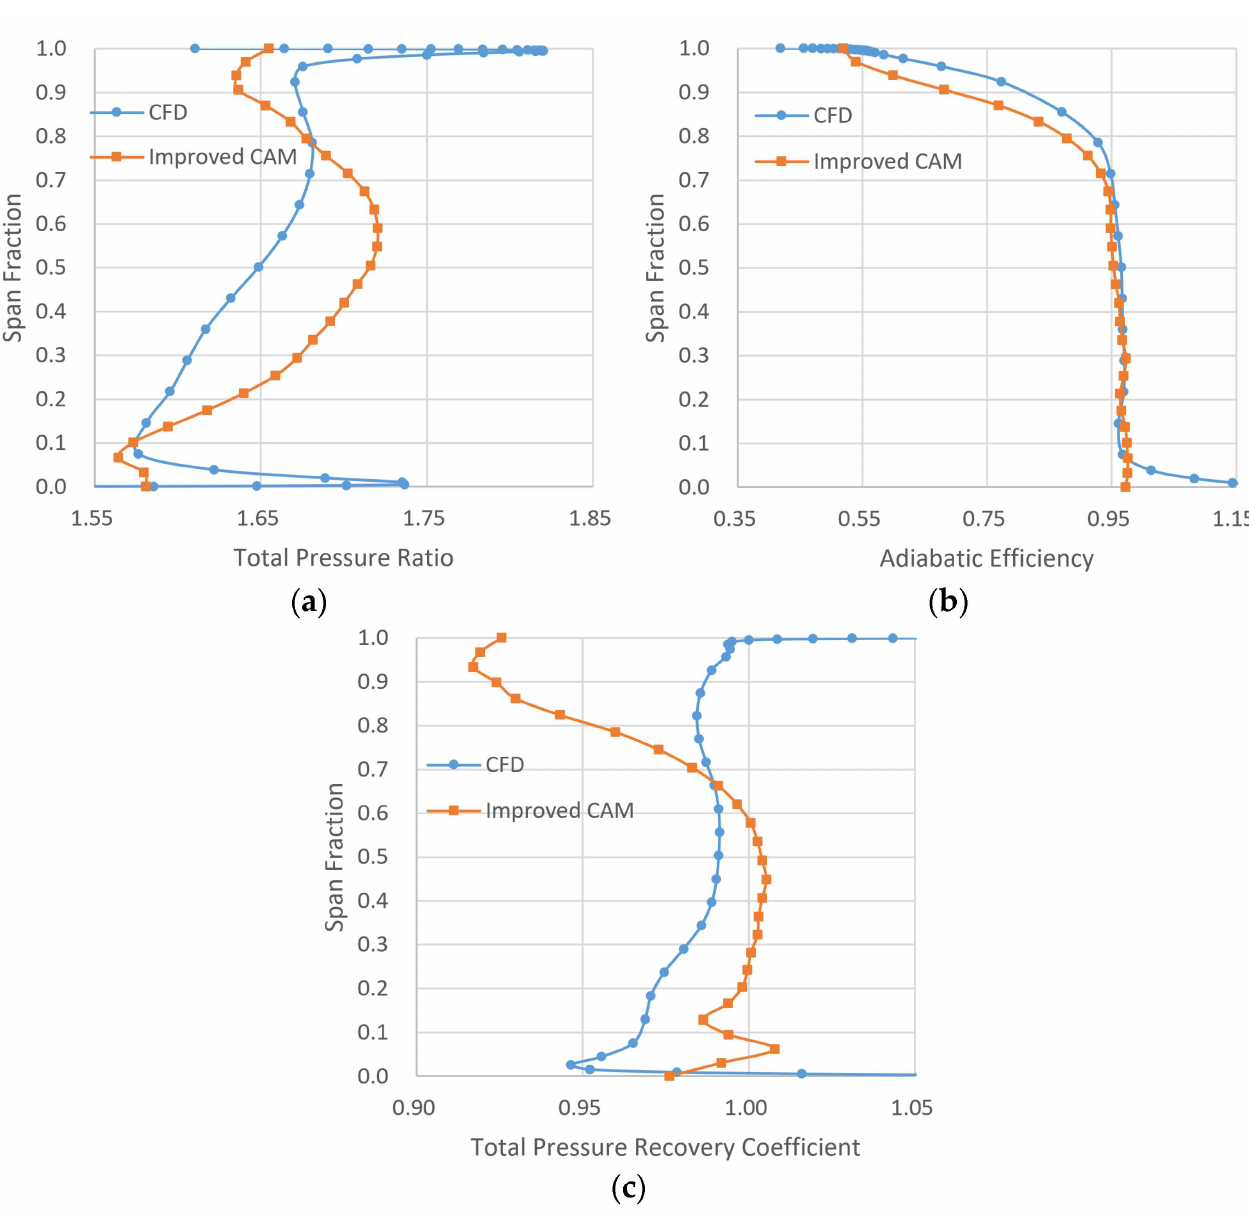
Figure 18. CFD vs. improved CAM span-wise distribution of the 11D compressor parameters with inlet distortion: ( a ) total pressure ratio of rotor; ( b ) adiabatic efficiency of rotor; ( c ) total pressure recovery coefficient of